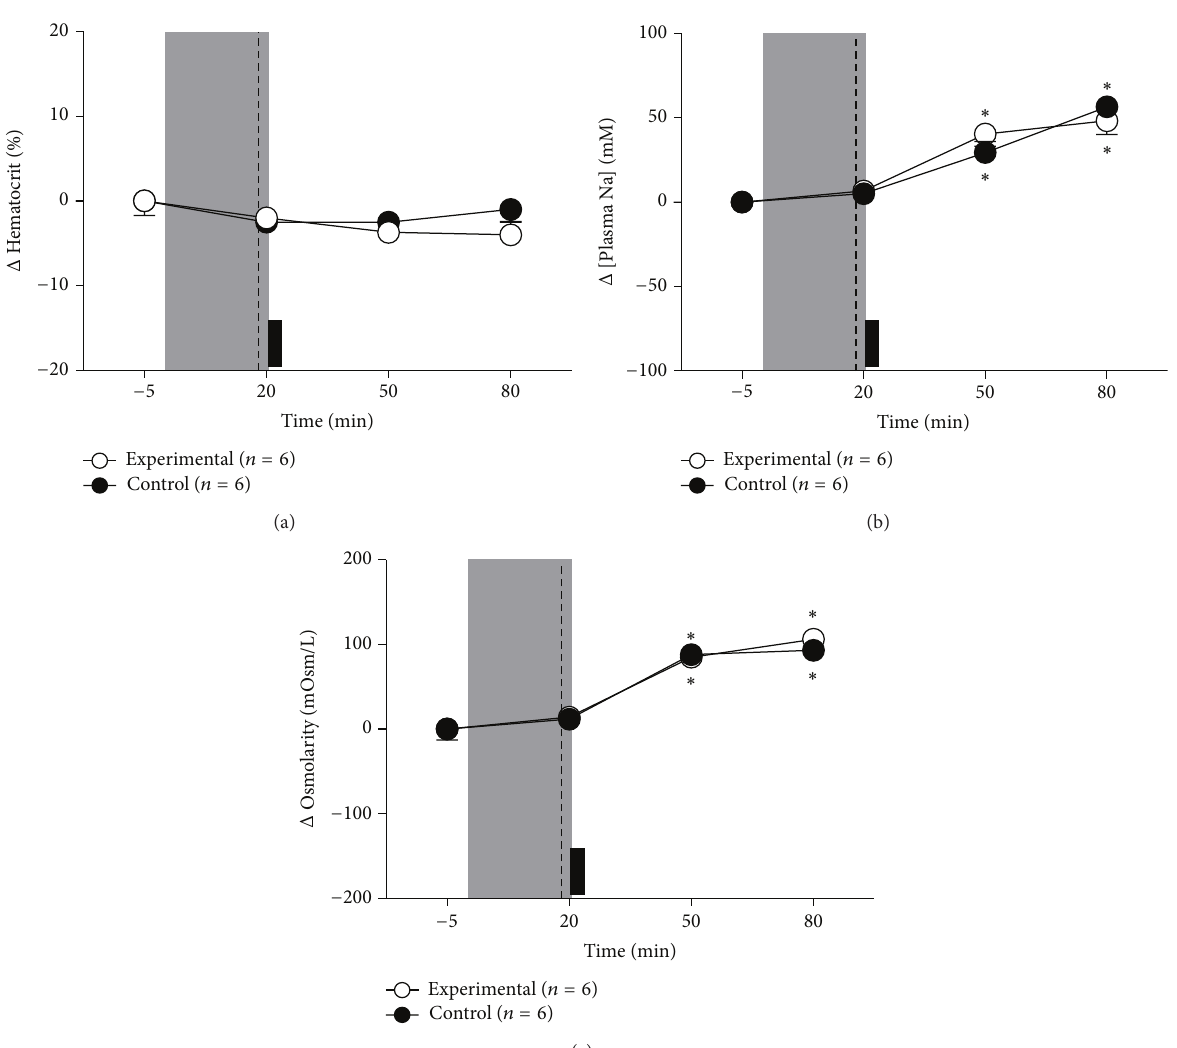
Figure 4: Effects of pharmacological blockade of the MnPO on changes in hematocrit level (a), plasma sodium concentration (b), and osmolarity (c) induced by hypertonic saline infusion in rats submitted to hemorrhage. Control group received nanoinjections of 150mM NaCl ( 𝑛 = 6 ) and experimental group received nanoinjections of 4mM Muscimol ( 𝑛 = 6 ) groups. ∗ Different from baseline, 𝑃 < 0.05 . The shaded area indicates the period of hemorrhage. Dashed line represents the moment of nanoinjection into the MnPO (muscimol or vehicle) and the black block indicates intravenous hypertonic saline